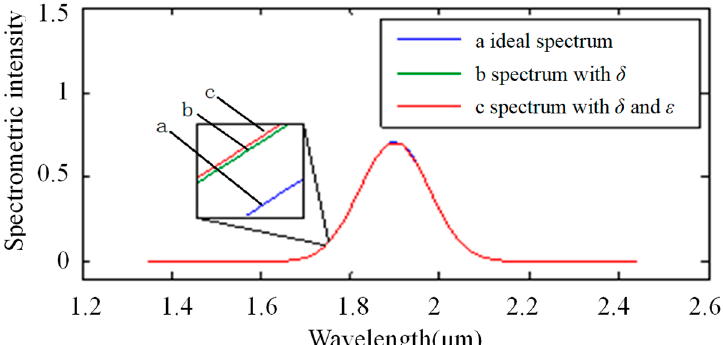
Figure 9. Result of stray light on the absorption spectrum in Hadamard multiple-stripe mode: the horizontal ordinate shows the wavelength with units of micrometers. Additionally, the longitudinal coordinate shows the spectrometric intensity. Curve a shows the ideal spectrum, curve b shows the spectrum with the noise of variable stray light, and curve c shows the spectrum with the noise of two types of stray light, including variable stray light and intrinsic stray light.